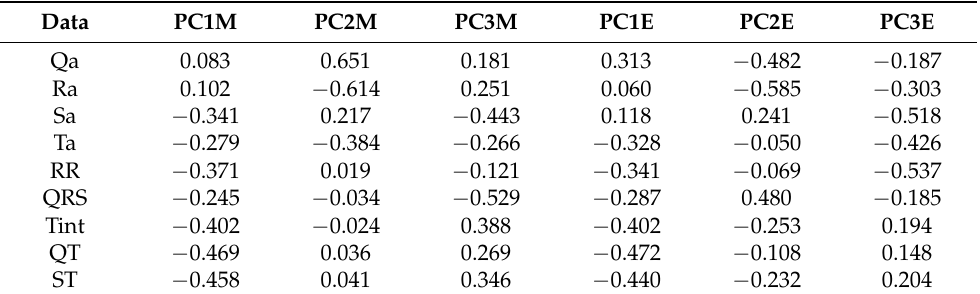
Table 5. Summary of the first three principal components using factored data (morning data (M):